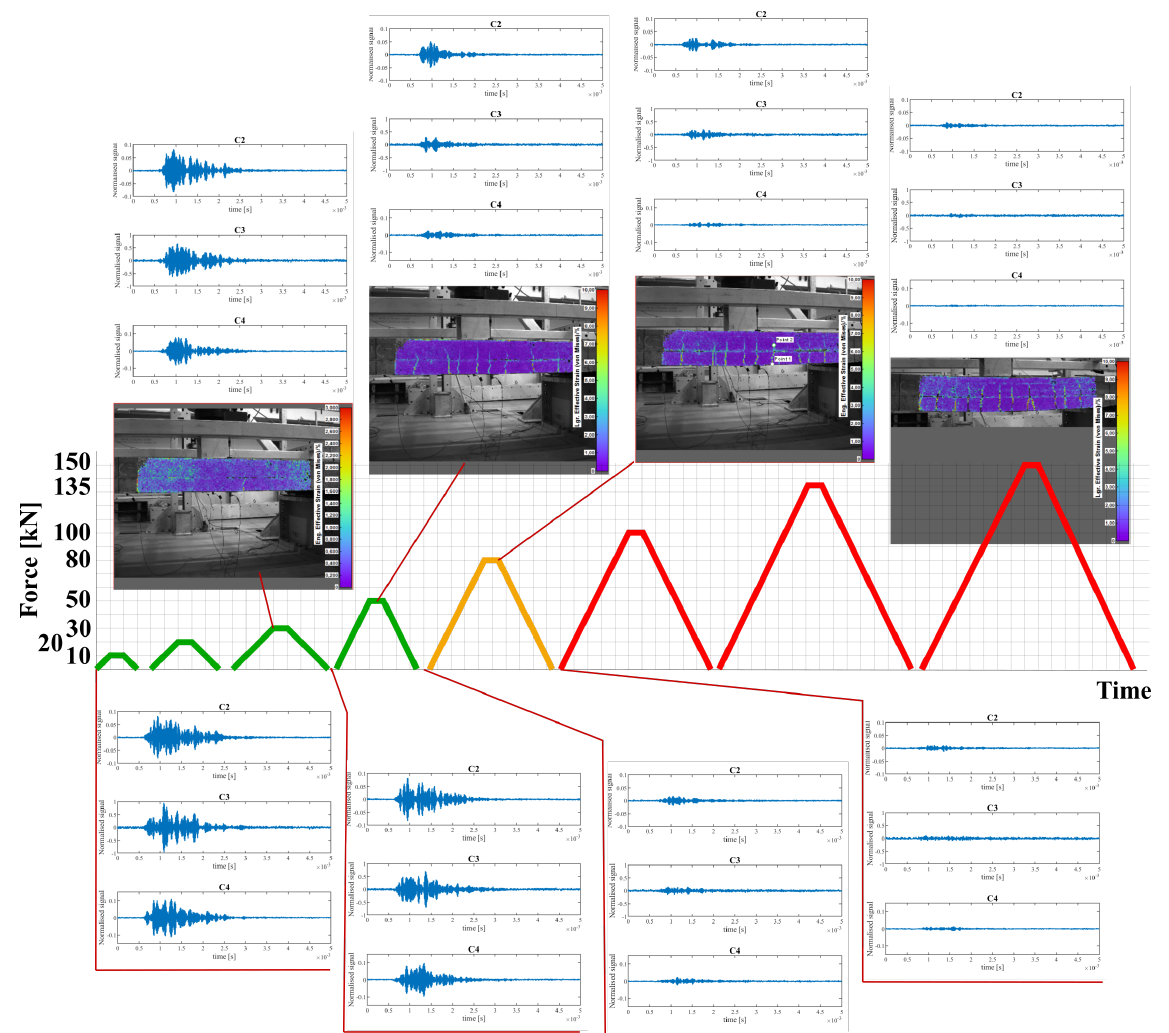
Figure 6. Loading cycles and their corresponding crack appearance and changes in the signals registered by the PZT sensors. Green indicates the loading cycles were signed and the slab was in a ‘healthy’ state. Orange indicates alarm loading cycles. The final cycles are marked with red and indicate the slab should be treated as